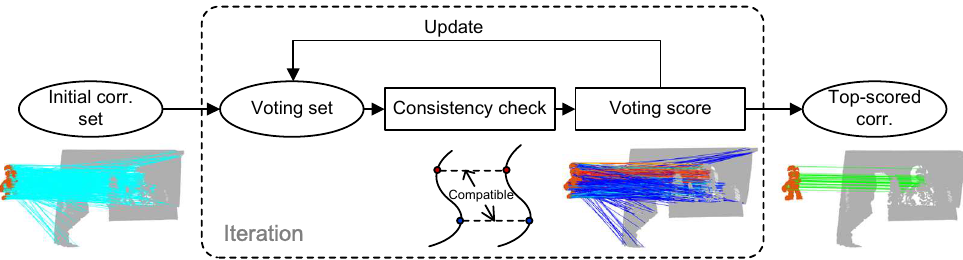
Figure 1. Pipeline of the proposed PCV method. Given initial correspondences (cyan lines), PCV iteratively updates the voting set, checks the geometric conistency of each correspondence with the voters in the voting set, and assigns a voting/confidence score to each correspondence (rendered in colored lines). Consistent correspondences (green lines) can be found by simply ranking the correspondences based on voting